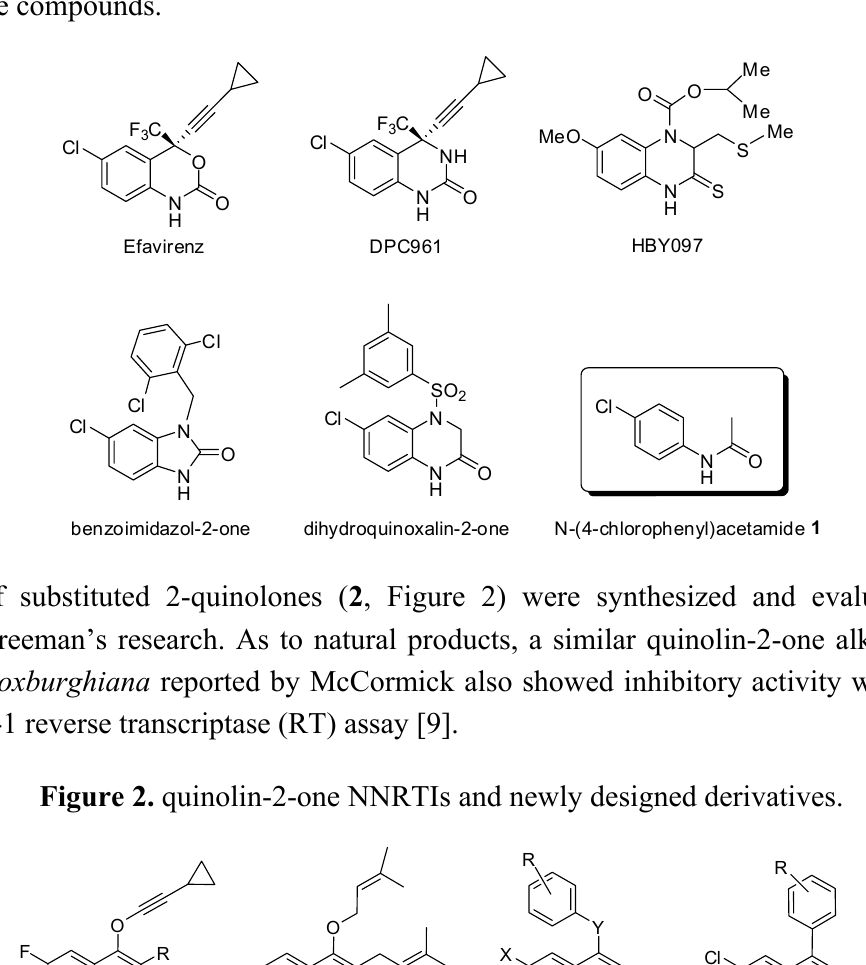
Figure 1. NNRTI pharmacophore N -(4-chlorophenyl)acetamide ( 1 ) and related anti-HIV-1 RT active compounds.